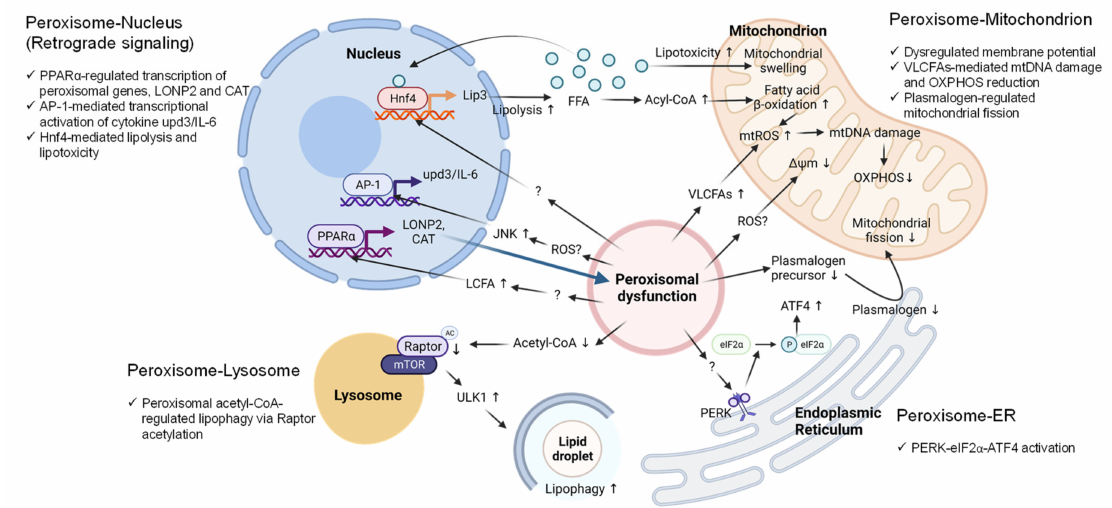
Figure 3. Metabolic and molecular signaling pathways mediate peroxisome-organelle crosstalk in response to peroxisomal dysfunction. (1) Peroxisome-nucleus: Peroxisomal dysfunction activates nuclear gene transcription through the transcription factors PPAR α , AP-1, or Hnf4. The accumula- tion of long-chain fatty acids (LCFAs) activates PPAR α to upregulate LONP2 and CAT expression to restore peroxisomal function (Blue arrow). Elevated ROS activates JNK signaling and AP-1 to induce the transcription of the pro-inflammatory cytokine IL-6 . Peroxisomal dysfunction activates Hnf4 through unknown mechanisms to induce the expression of lipase 3 (Lip3) , which leads to excessive free fatty acids (FFA) in the cytoplasm. FFAs hyper-activate Hnf4 via a positive feed- back loop. (2) Peroxisome-mitochondrion: Peroxisomal dysfunction causes mitochondrial swelling, mitochondrial ROS generation, mitochondrial DNA (mtDNA) damage, disruption of oxidative phosphorylation (OXPHOS), and decreased inner membrane potential. Excessive ROS and elevated VLCFA are the potential signaling molecules that mediate the peroxisome-mitochondrion crosstalk. Peroxisomal dysfunction decreases plasmalogen, resulting in the inhibition of mitochondrial fission. (3) Peroxisome-ER: Peroxisomal dysfunction activates PERK signaling through unknown mechanisms to increase the phosphorylation of eIF2 α and ATF4 induction. (4) Peroxisome-lysosome: Peroxisomal dysfunction due to the loss of Acox1 decreases peroxisome-derived acetyl-CoA, resulting in Raptor acetylation and lysosome localization of mTOR, leading to ULK1 activation and elevated